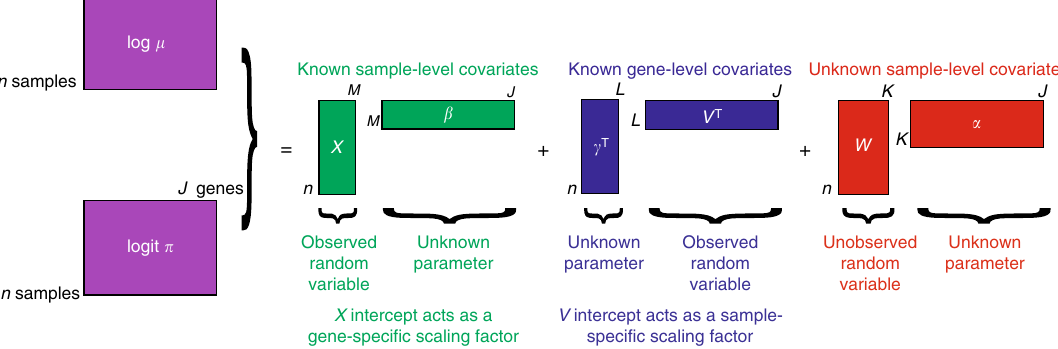
Fig. 1 Schematic view of the ZINB-WaVE model. Given n cells and J genes, let Y ij denote the count of gene j ( j = 1, … , J ) for cell i ( i = 1, … , n ) and Z ij an unobserved indicator variable, equal to one if gene j is a dropout in cell i and zero otherwise. Then, μ ij ¼ E Y ij j Z ij ¼ 0 ; X ; V ; W ½ (cid:2) and π ij ¼ Pr Z ij ¼ 1 j X ; V ; W ð Þ . We model ln( μ ) and logit( π ) with the regression speci fi ed in the fi gure. Note that the model allows for different covariates to be speci fi ed in the two regressions; we have omitted the μ and π indices for clarity (see Methods